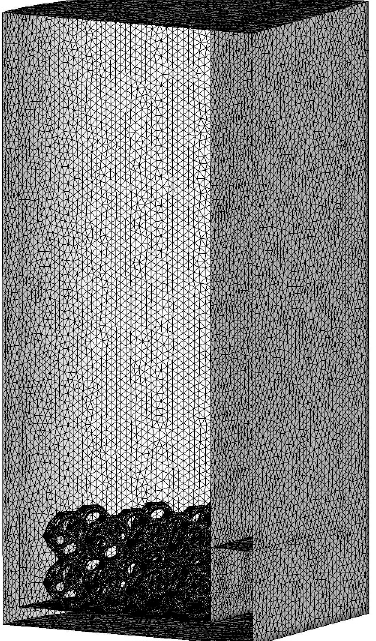
Figure 5. Mesh of paraffin/copper foam composite PCM.